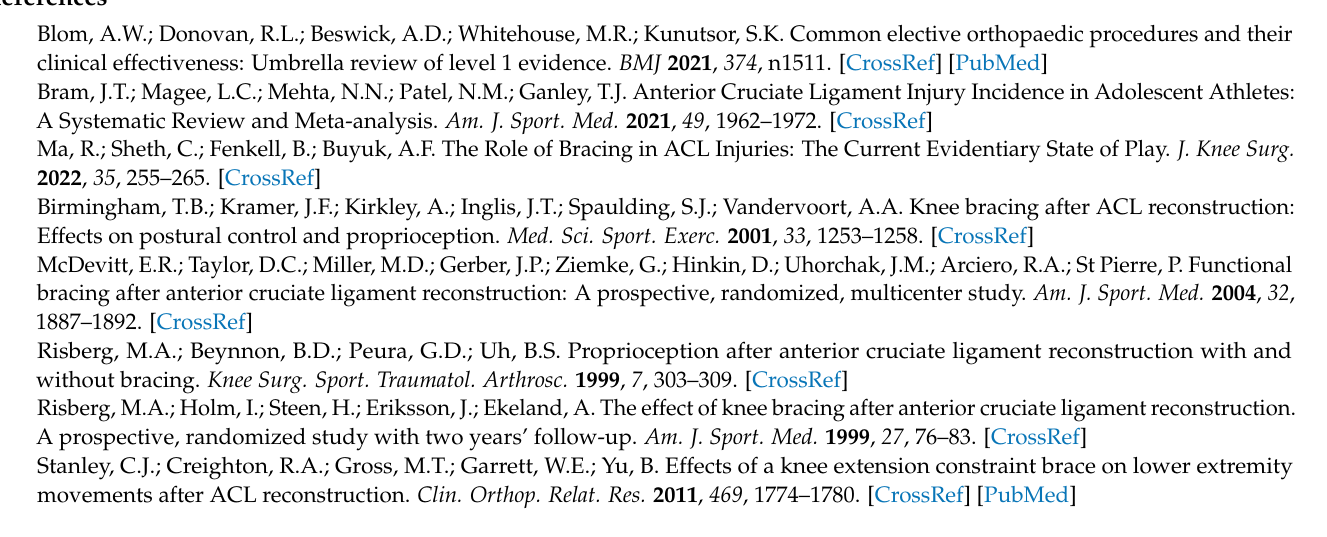
Figure A2. DONJOY 4TITUDE brace, ORMED GmbH, Freiburg, Germany ( https://www.ortho- team.ch/produkte/knie-2/knieorthese-donjoy-4titude, accessed on 4 January 2023).